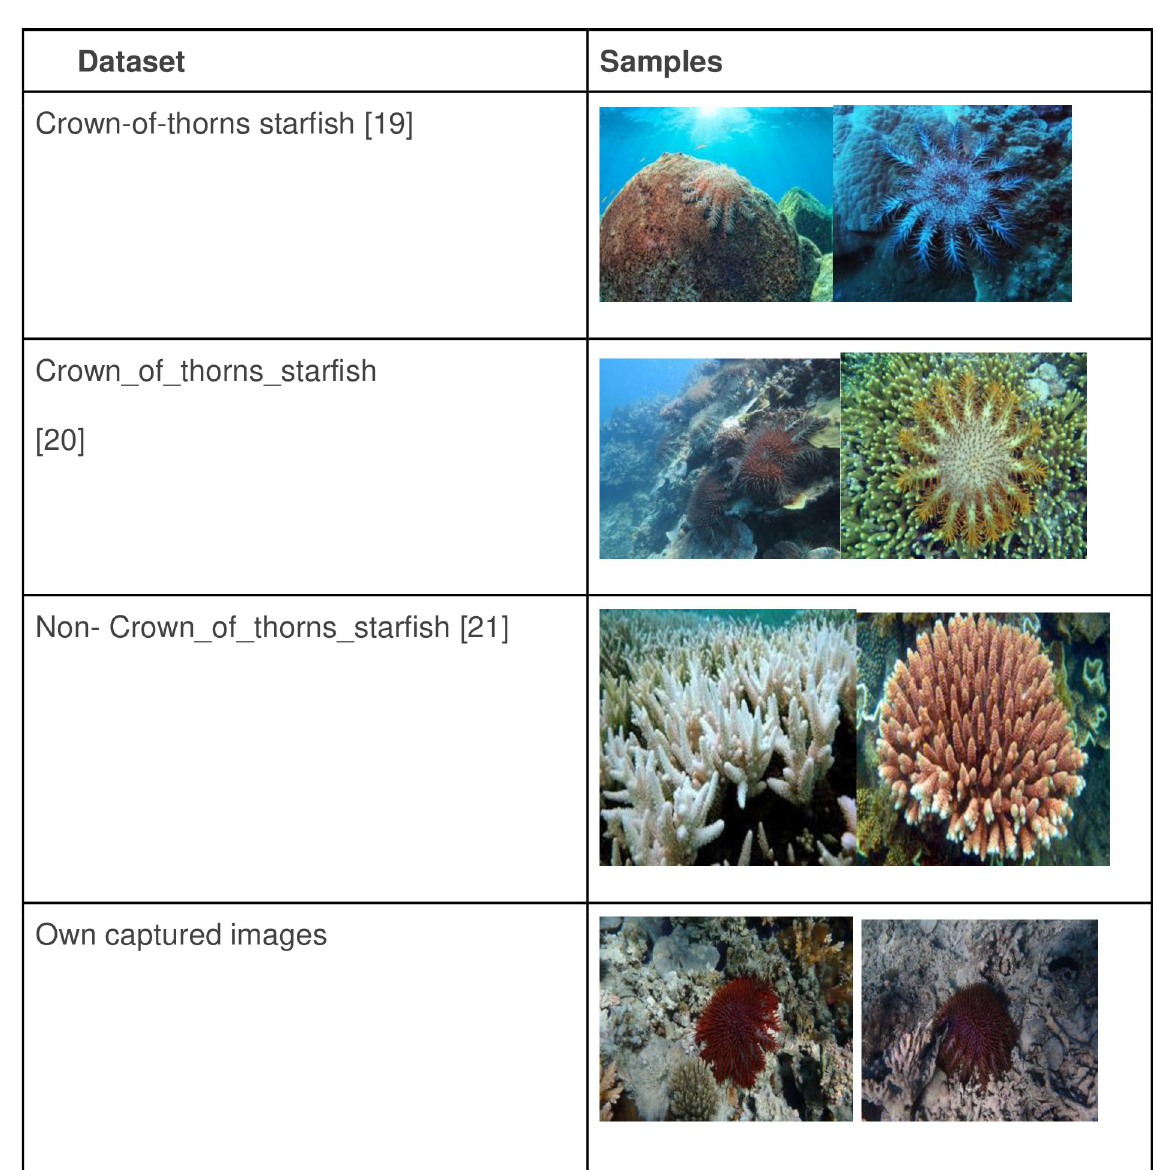
Fig 2. COTS and non-COTS